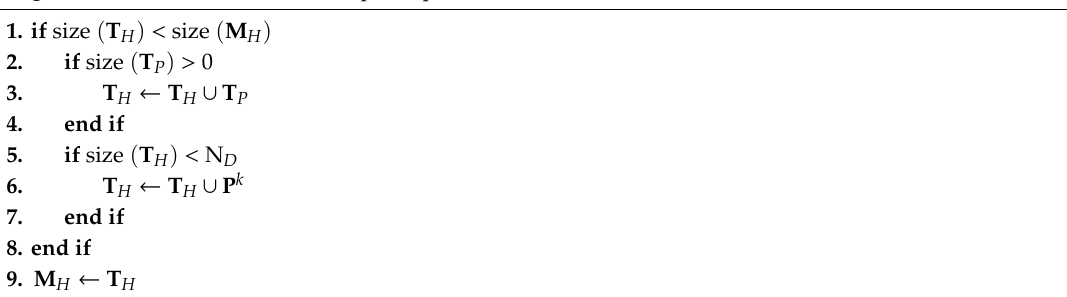
Algorithm 3. Pseudo-code for the update